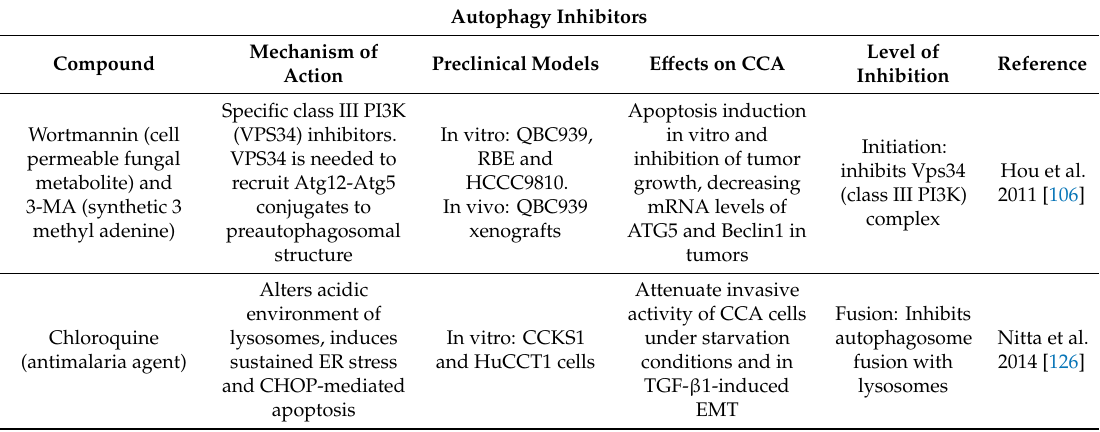
Table 2. Preclinical studies with autophagy modulators in CCA. * Uncomplete mechanism of